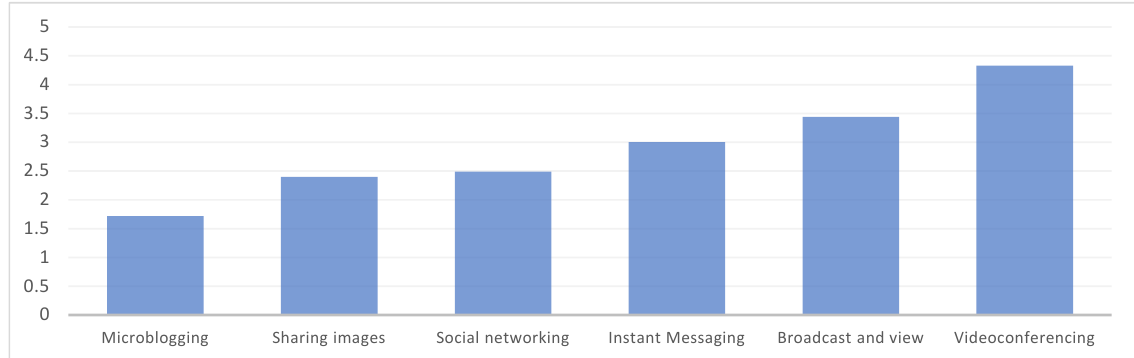
Figure 4. Average frequency of use of digital tools or applications for instructional design.